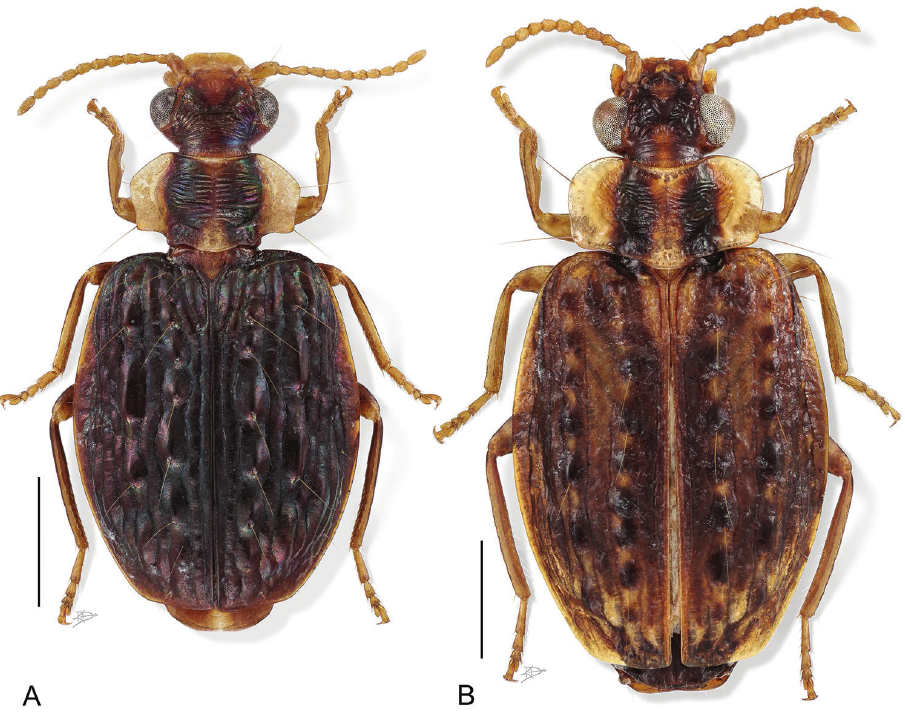
Figure 6. Digital Photo-illustration. Habitus, dorsal aspect. A Hyboptera apollonia Erwin, male, ADP007944 B Hyboptera auxilidora Erwin, male, ADP007622. Color: See diagnosis,